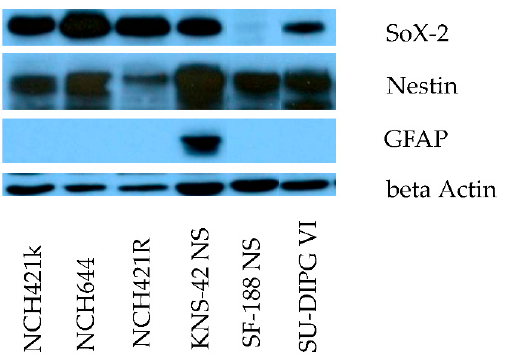
Figure 2. Stem-like cell expression pattern in HGG neurosphere culture models. Expression of neuroepithelial stem cell marker proteins SOX-2 and Nestin, and the astrocyte lineage marker GFAP in neurosphere cultures by Western blot. Detection of beta actin served as loading control.